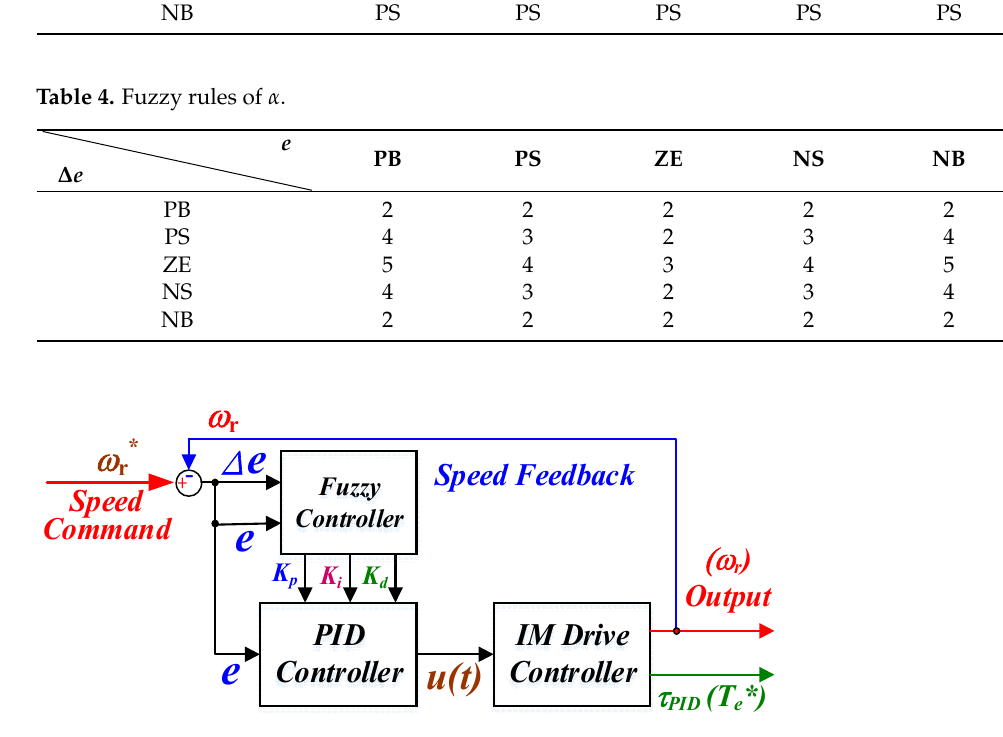
Table 5. Rules for the seven-stage fuzzy controller.